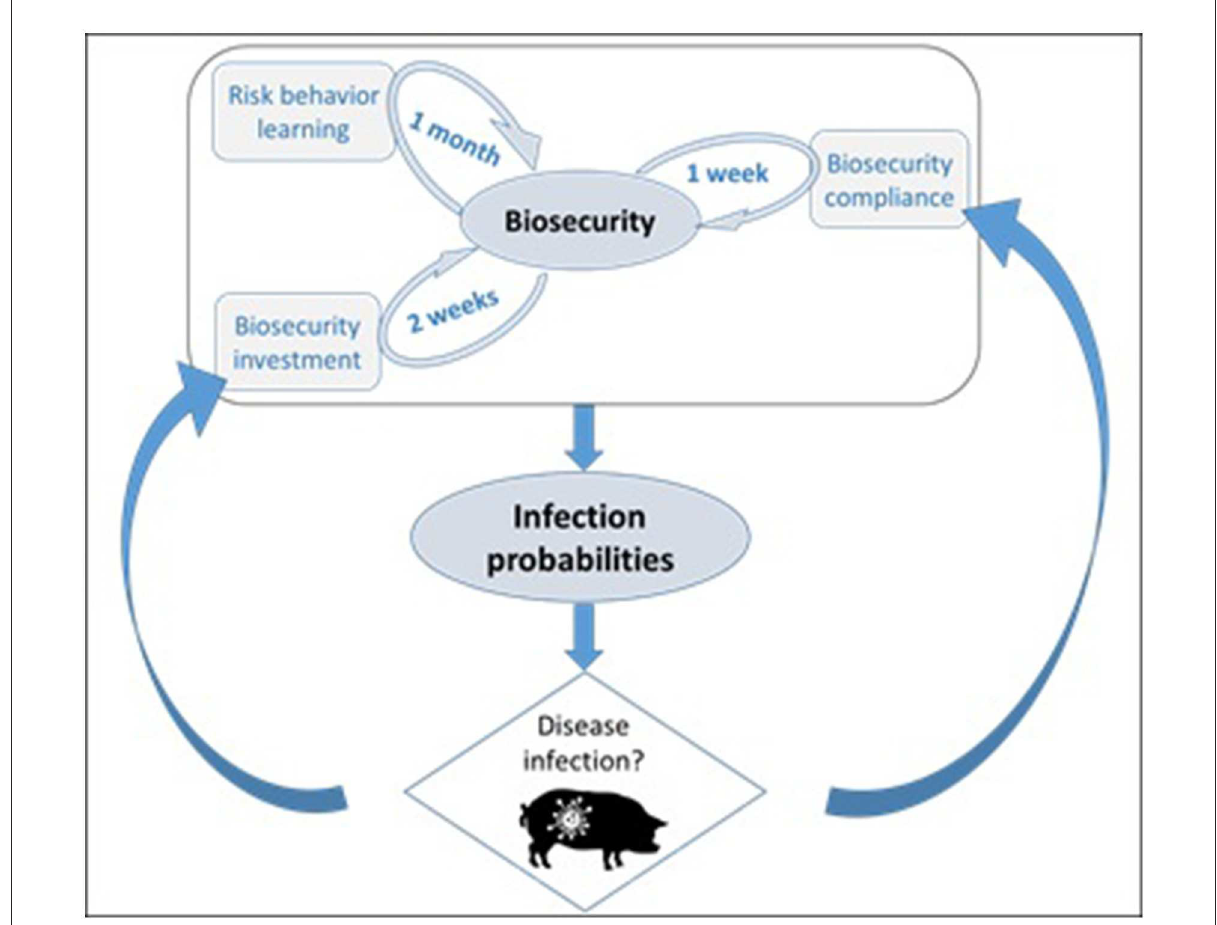
FIGURE1 Infection probability is directly related to biosecurity in the ABM. The biosecurity level of a hog-producer agent in the model depends on its compliance, willingness of making biosecurity investments and on its risk attitude, which can change with time (learning). Disease infection feeds back in biosecurity in two ways: biosecurity investments in response to disease vicinity, and full compliance when a premises turns symptomatic. The implemented learning mechanism is agnostic and therefore independent of simulated disease conditions.